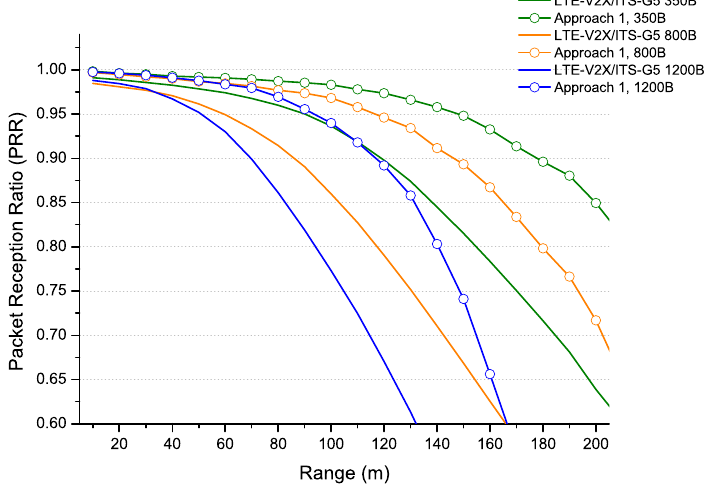
Figure 15. Coexistence LTE-V2X/ITS-G5: density sharing for different packet